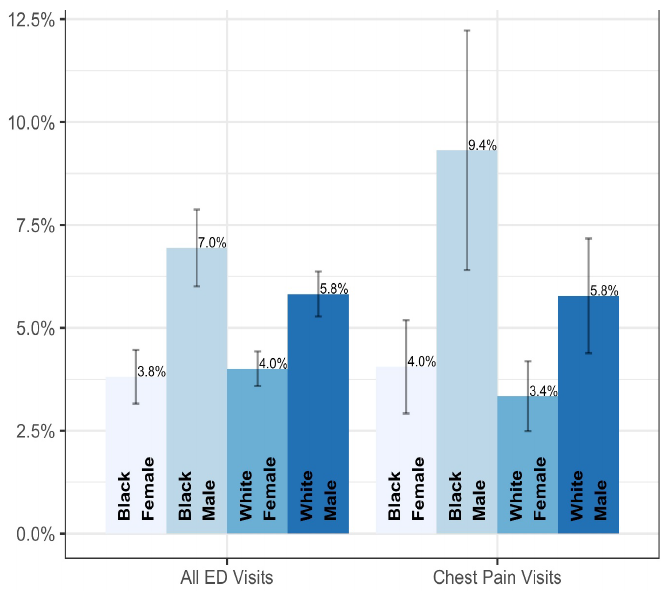
Figure 1. Urine drug screen utilization by gender and race, with 95% confidence